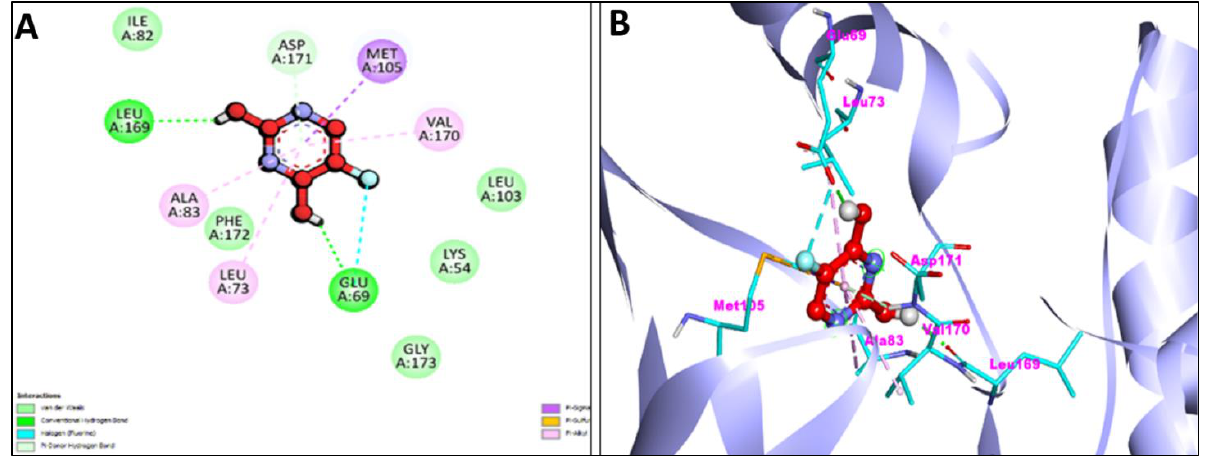
Figure 13. 2D ( A ) and 3D ( B ) representation of interaction of anti-cancerous drug fluorouracil and human Traf2- and Nck- interacting protein Kinase (purple color with ribbon pattern) (PDB:2X7F).